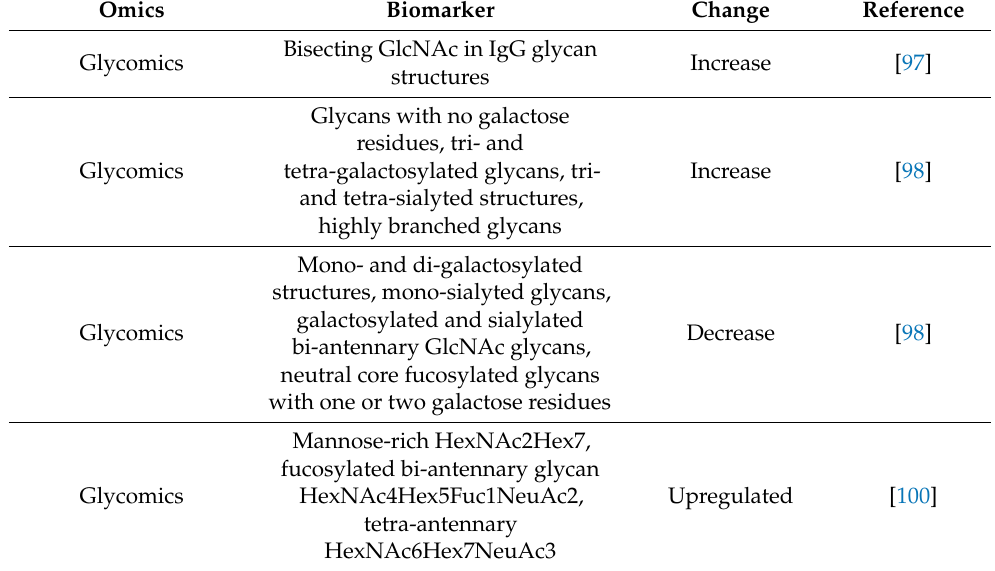
Increase [97] Increase [98] Decrease [98]